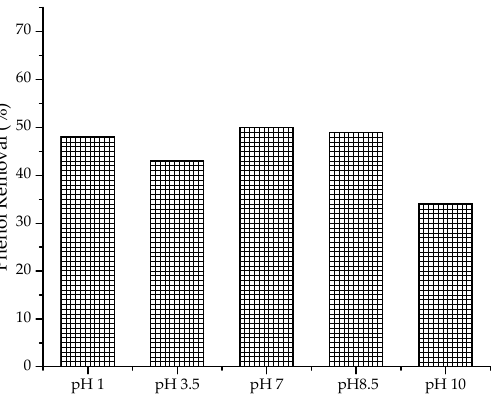
Figure 8. Phenol removal after 5 h of UV irradiation, at different pH of the initial phenolic solution (0.0125 g of catalyst, 500 μ L of platinum solution). Colors indicate different pH.